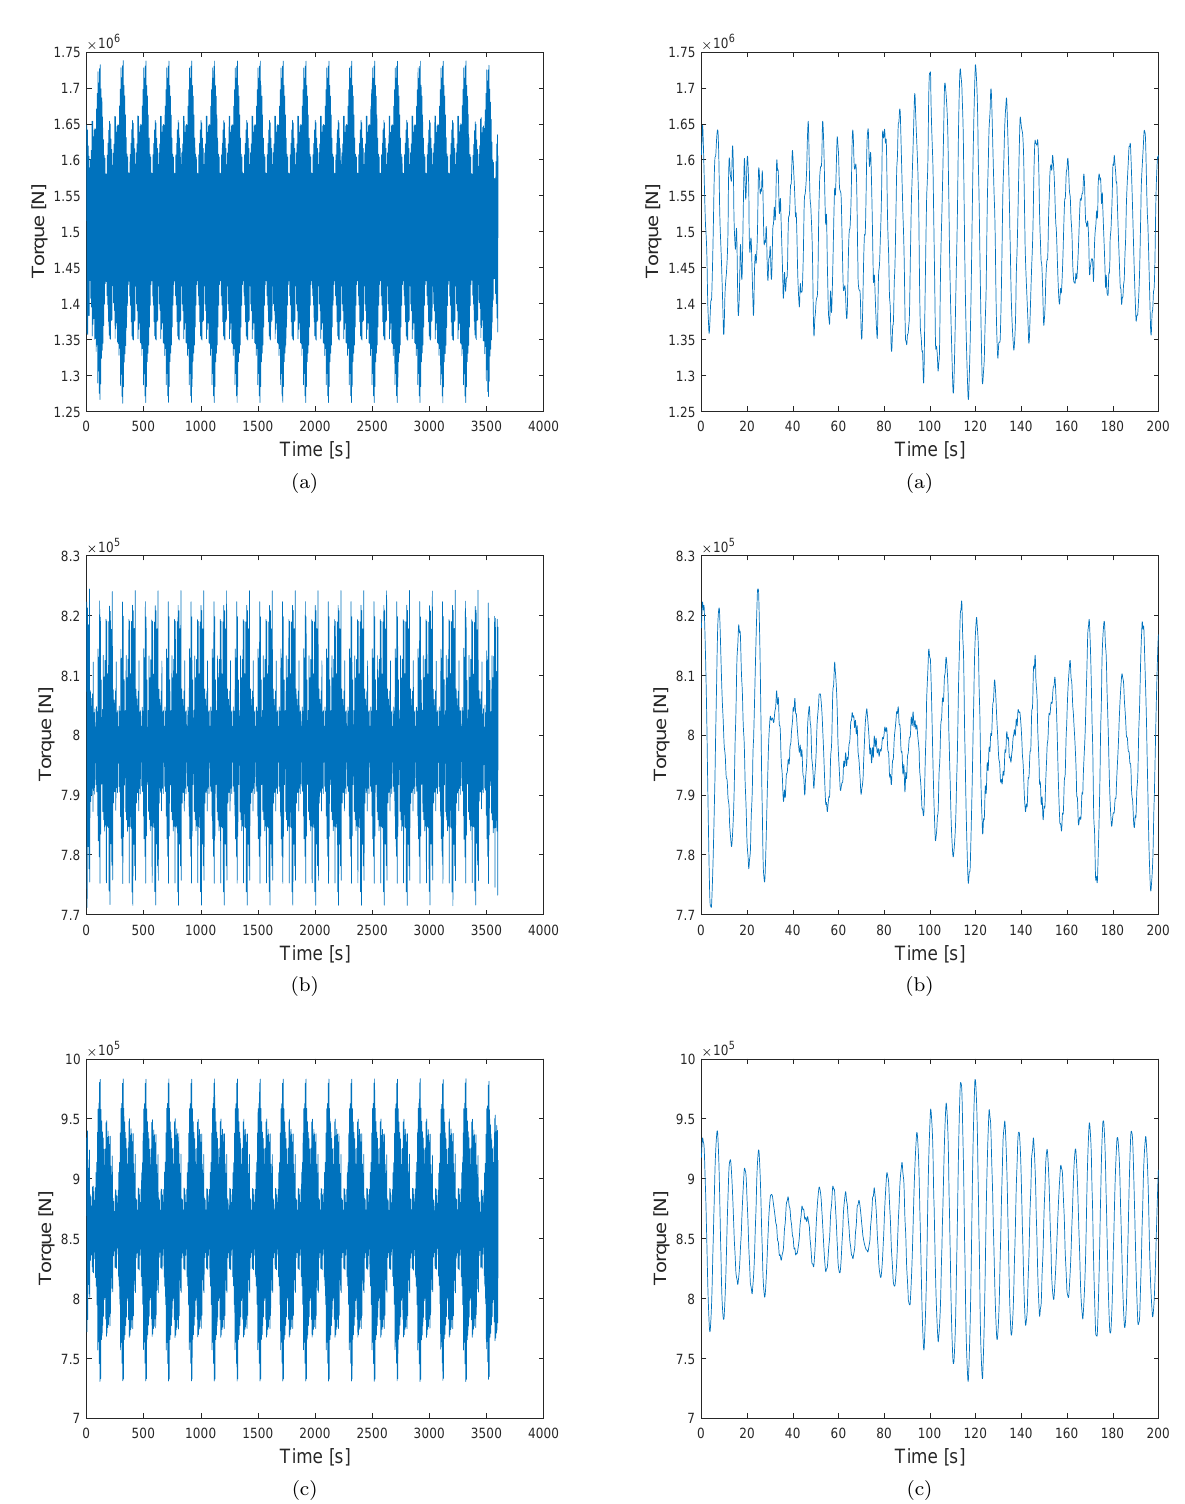
Figure 7: 18 cycles of torque on winch drivetrain us- ing Rope A, B and C from top to bottom respectively